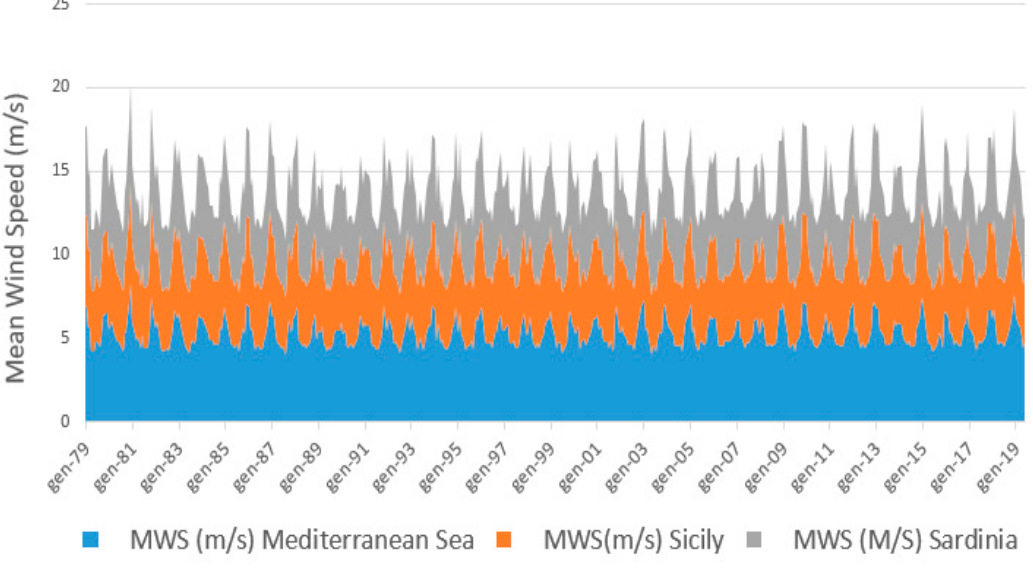
Figure 6. Mean wind speed (MWS) per (m/s) with the 10 m height in two different cases and Mediterranean Sea using European Centre for Medium-Range Weather Forecasts (ECMWF) reanalysis dataset (between 1979 to 2019).